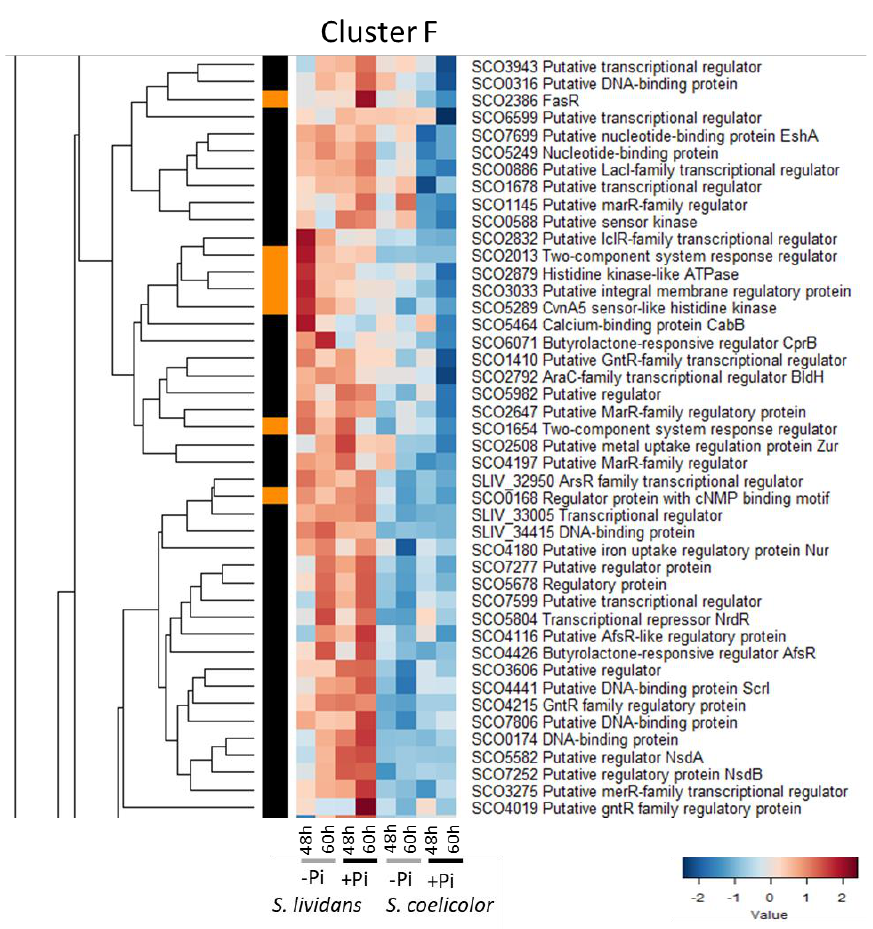
Figure 7. Cluster F, heatmap representation of transcriptional regulators and sensory histidine kinases more abundant in SL than in SC in both Pi conditions.